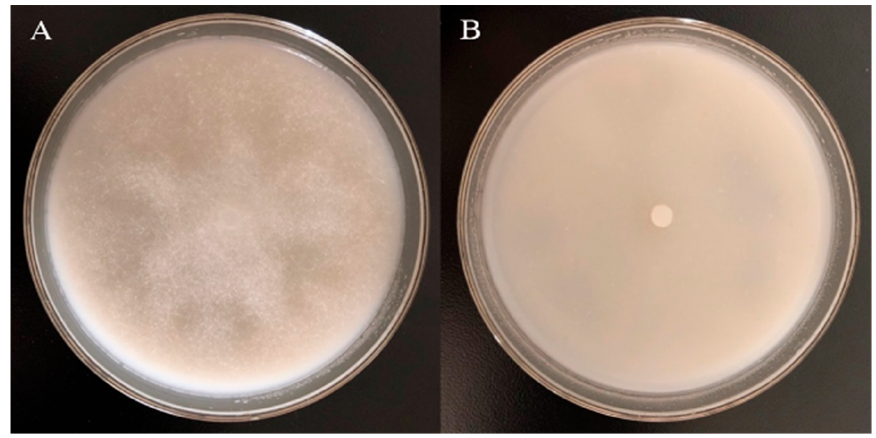
Figure 2. Fumigation effect of 20 μ L/L DADS on P. nicotianae . ( A ) Control; ( B ) mycelia treated with 3 μ L/dish (equivalent to fumigation concentration 20 μ L/L) of DADS.